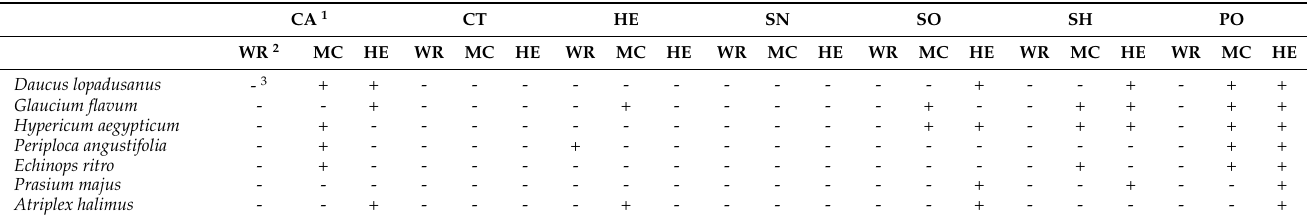
Table 3. Phytotoxic effects of extracts and water residue in the leaf puncture assay. CA 1 CT